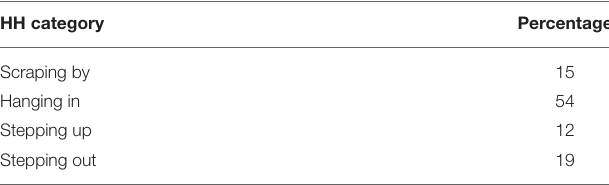
TABLE 1 | Results of household categorization, Hoima, n =